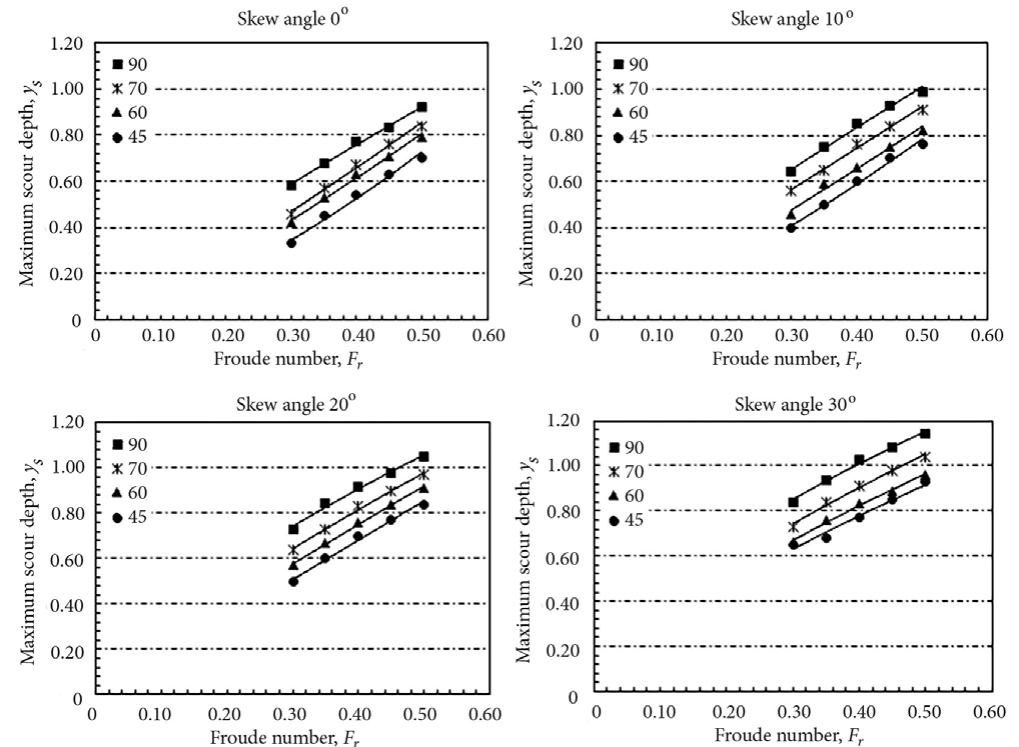
Figure 4. The scour depth against Froude number for bridge piers with different skew angle and for different nose angles